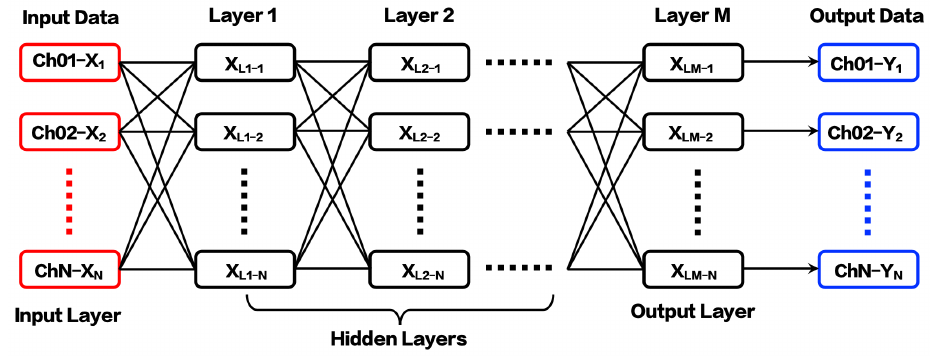
Figure 5. CNN learning algorithm for deep